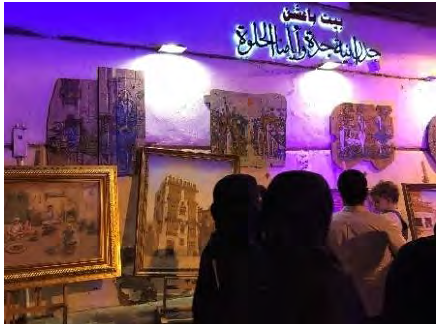
Figure 9. Show art exhibition for talented people